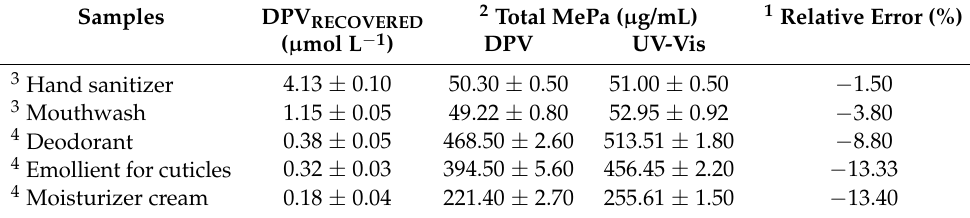
Table 2. Results for the determination of MePa by UV-vis and DPV techniques. Samples DPV